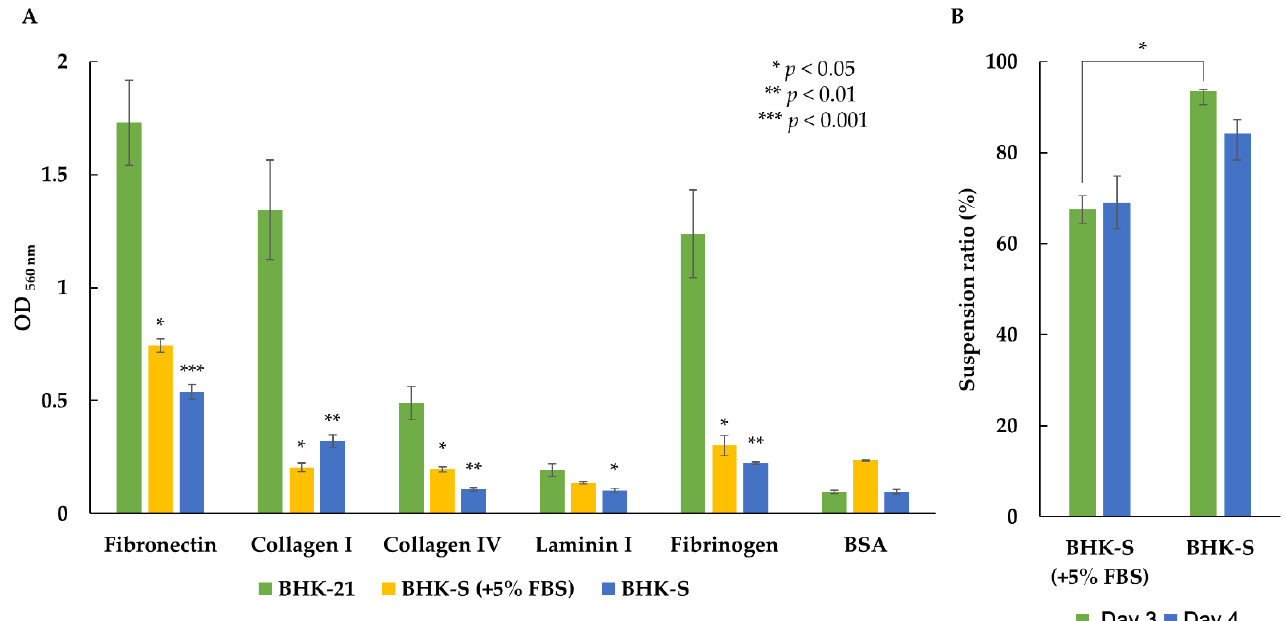
Figure 2. Suspension BHK-S cells and intermediately adapted BHK-S cells (+5% FBS) showed reduced cell attachment to the ECM proteins fibronectin, collagen type I, collagen type IV, laminin I, and fibrinogen ( A ). Colorimetry was performed to quantify the OD 560 nm values after cell staining and extraction. The BHK-S cells showed less aggregation than the intermediately adapted BHK-S cells (+5% FBS) ( B ). Each experiment was carried out in triplicate. Data expressed as mean ± standard deviation. Statistical analyses were performed using Student’s t -test. p < 0.001 was considered statistically significant.